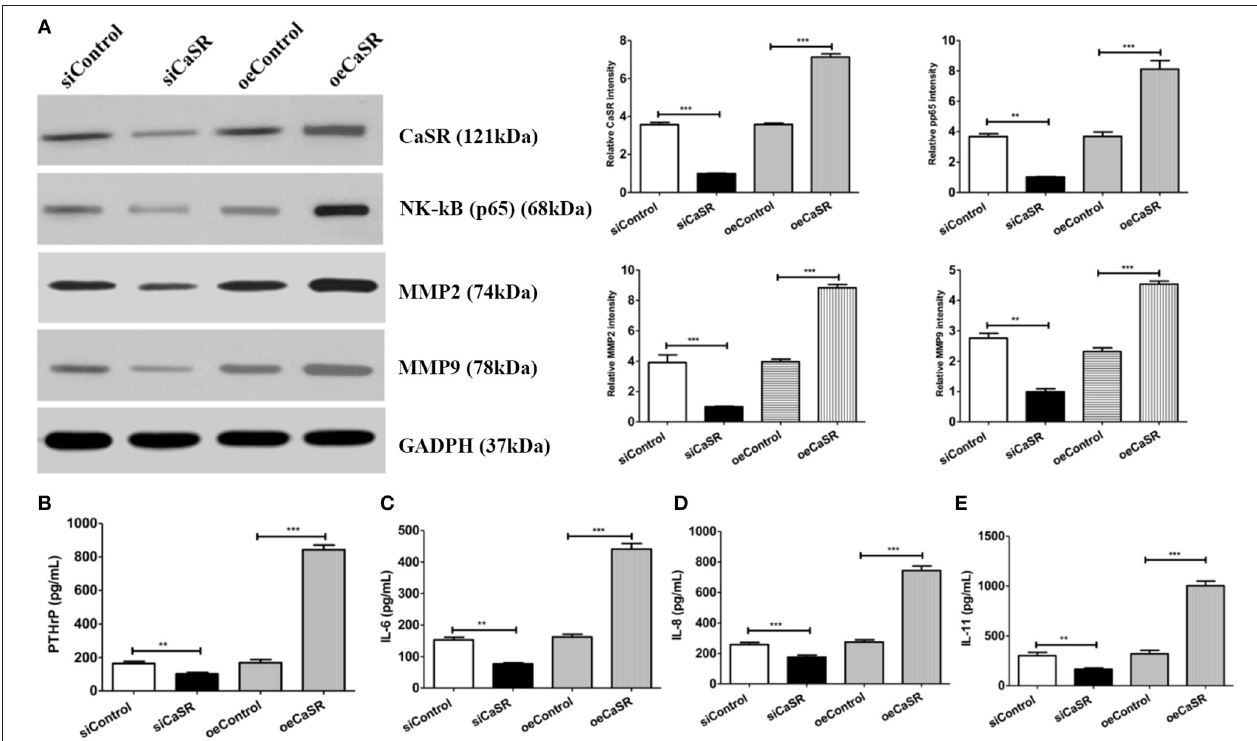
FIGURE 7 | Analysis of cytokine expression levels. (A) Western blotting confirmed NF- κ B, MMP2, and MMP9 expression levels. ImageJ software (NIH) was used for image processing to verify band intensities as a result of semi-quantitative western blots. NF- κ B expression level in CaSR overexpression group was significantly higher than that in empty vector and negative control groups. NF- κ B, MMP2, and MMP9 expression levels were significantly lower in CaSR knockdown group than in empty vector and negative control groups ( p < 0.001). (B) PTHrP expression levels in CM from modified A549 cells co-cultured with macrophages were detected by ELISA. PTHrP expression level was significantly higher in CaSR overexpression group than in empty vector and negative control groups. PTHrP expression level was significantly lower in CaSR knockdown group than in empty vector and negative control groups ( p < 0.001). (C–E) IL-6, IL-8, and IL-11 expression in CM from modified A549 cells co-cultured with macrophages were detected by ELISA. IL-6, IL-8, and IL-11 expression levels were significantly higher in CaSR overexpression group than in empty vector and negative control groups. Expression levels of these three factors were significantly lower in CaSR knockdown group than in empty vector and negative control groups ( p < 0.001). ** p < 0.01, *** p <